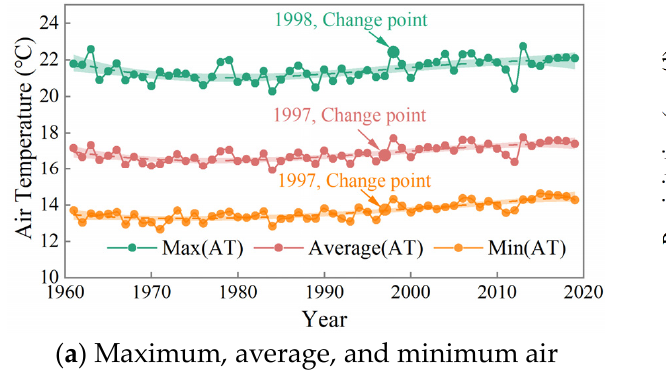
Figure 4. Mode decomposition of meteorological elements. 3.2. Climate Periods and Their Correlation Analysis